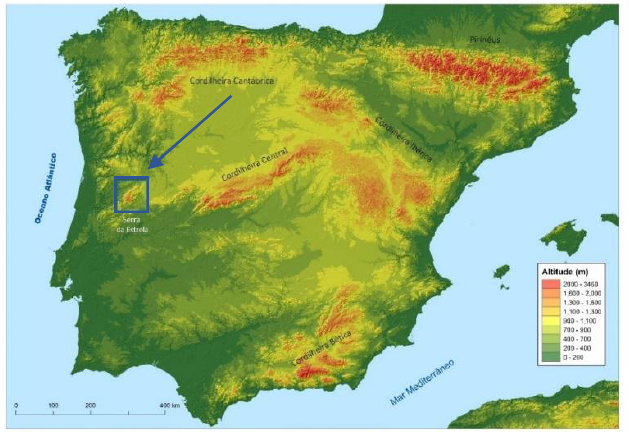
Figure 1. Location of the Estrela UNESCO Global Geopark on the Iberian Peninsula. It shows several permanent and temporary lakes, as well high-altitude peat bogs of high ecological value. Glacier erosion has been responsible for the removal of the granitic weathering